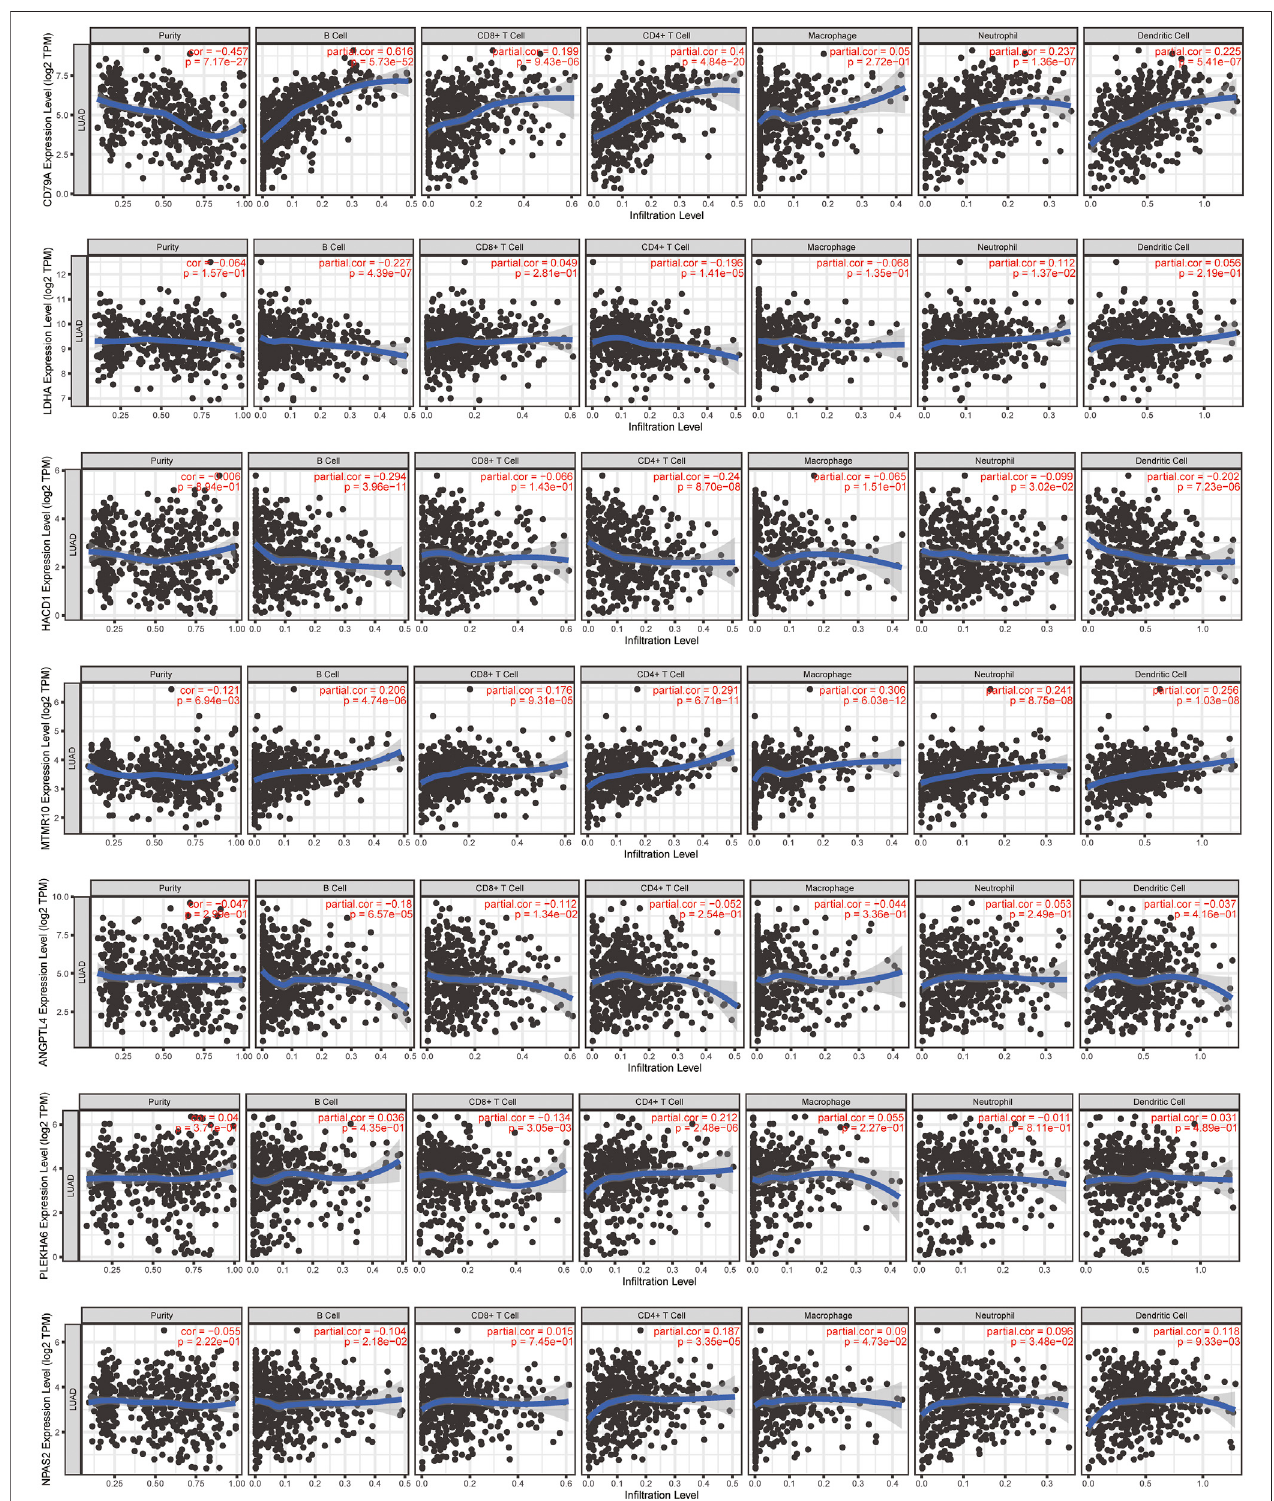
FIGURE10| Relationshipbetween11 lipidmetabolism-related genesand 6 kindsofimmunecellsusing the TIMER database. Thecorrelationscatter plot showed the relationship between 11 genes and in fi ltration of B cells, CD8 + T cells, CD4 + T cells, macrophages, neutrophils, and dendritic cells in LUAD.